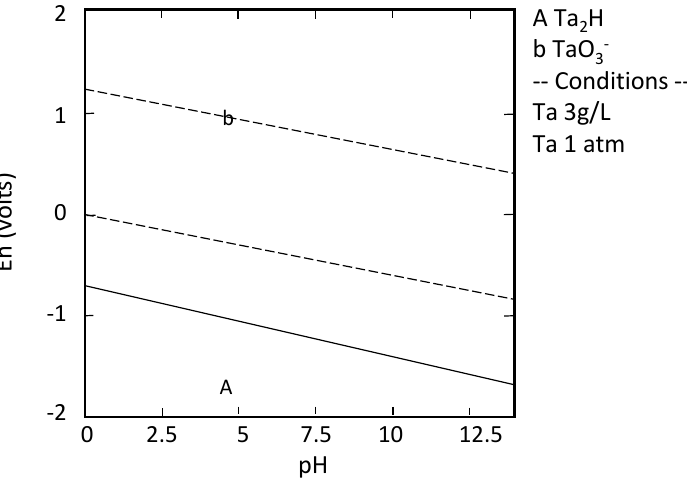
Figure 9. EpH diagram of Ta dependent of pH calculated by StabCal. Database used: HSC (Outotch).